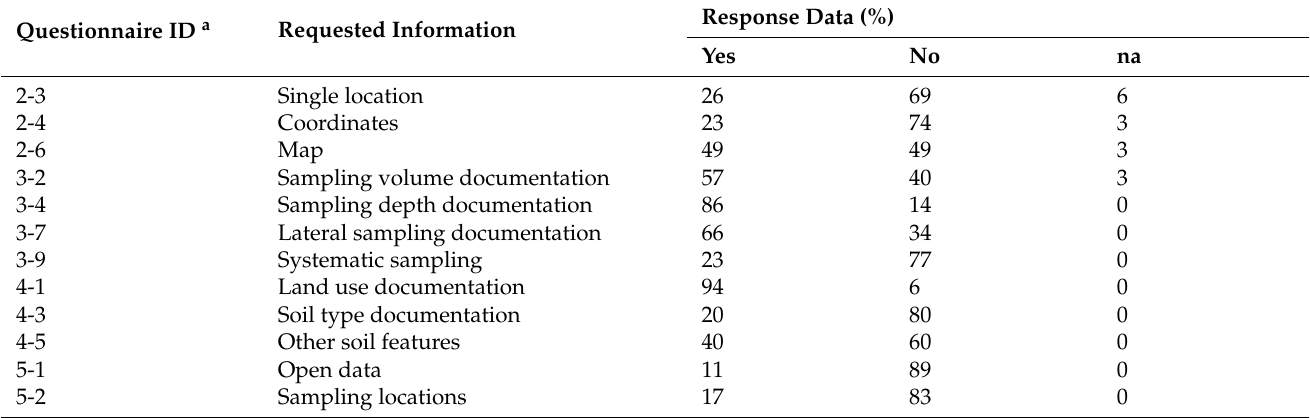
Table 3. Response data given in % on Yes-No questions from evaluated (n = 35)